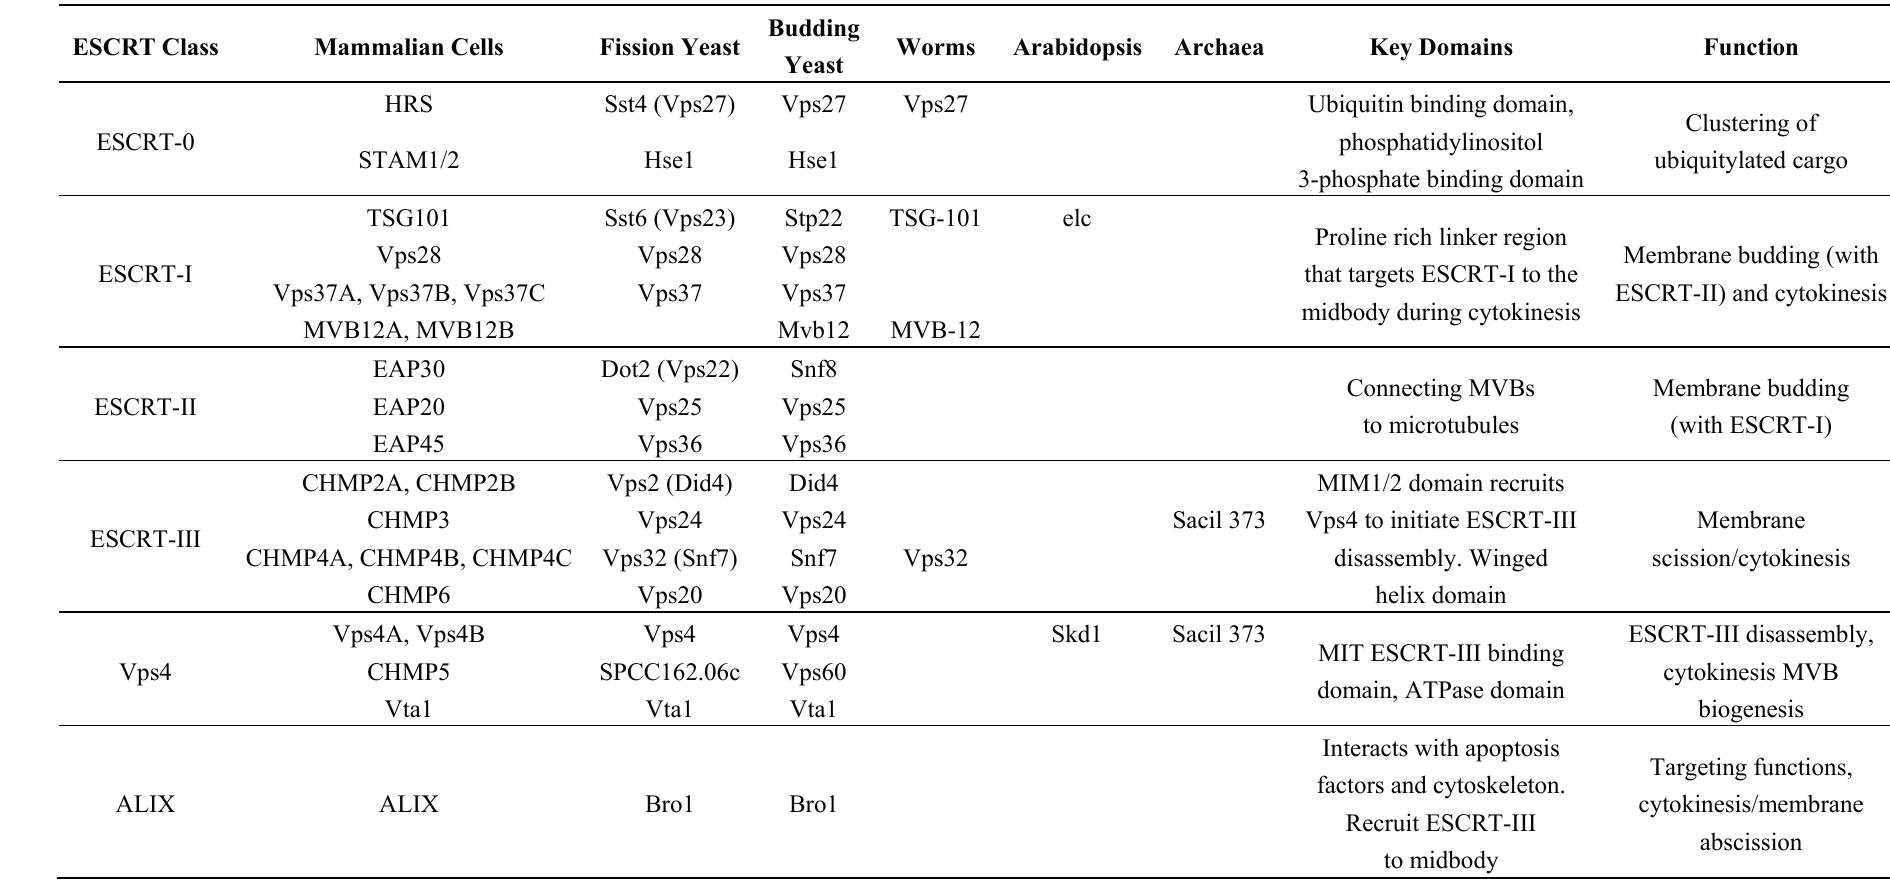
Table 1. Details of ESCRT genes in different